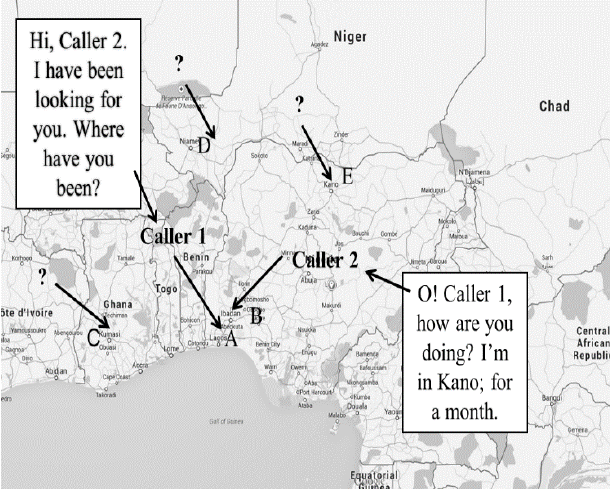
Figure 1. A 419 mobile phone conversation: giving a fake caller’s